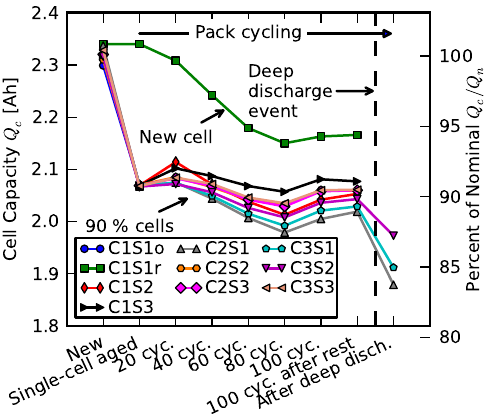
Figure 8. Capacities of individual cells in an early life failure scenario where one cell C1S1 is replaced with a new cell after 10% capacity fade. Traces are labeled by the site of the cell in the